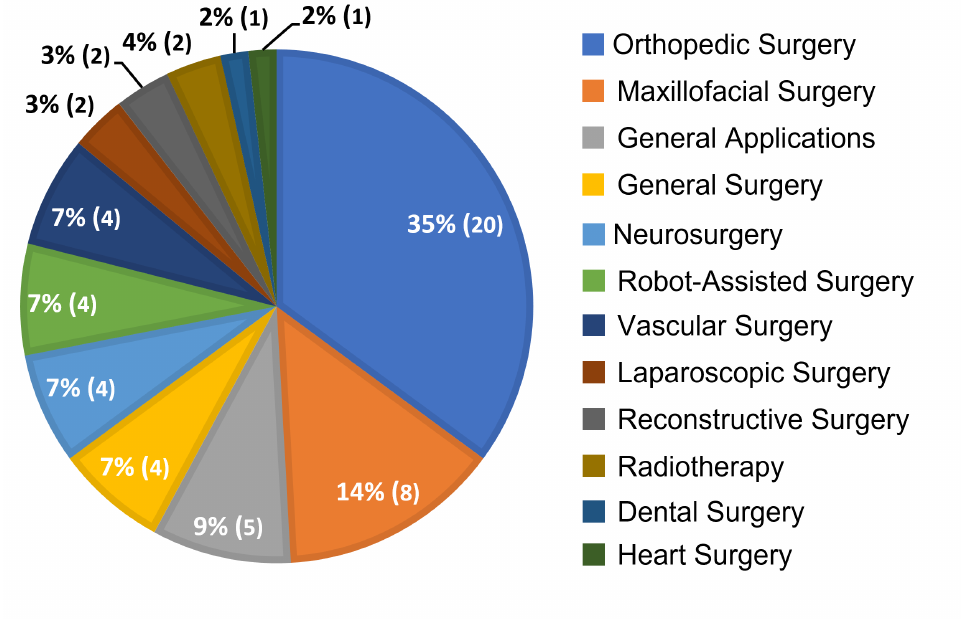
Figure 8. Distribution of the 57 articles included in the review based on the surgical speciality